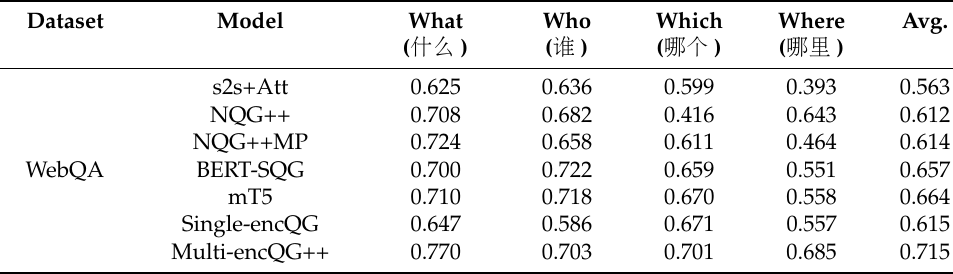
Table 7. The same question type ratio results of different question generation models.